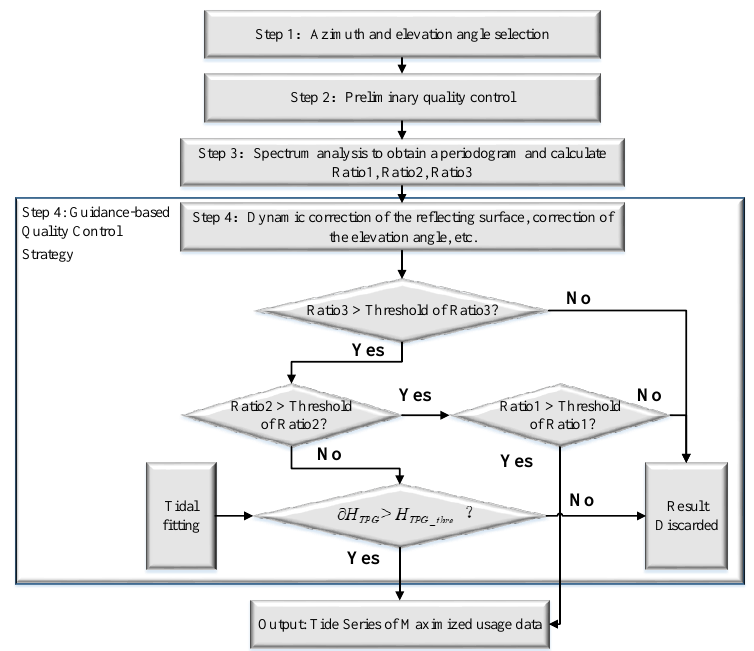
Figure 7. Flow chart of the TPG method.